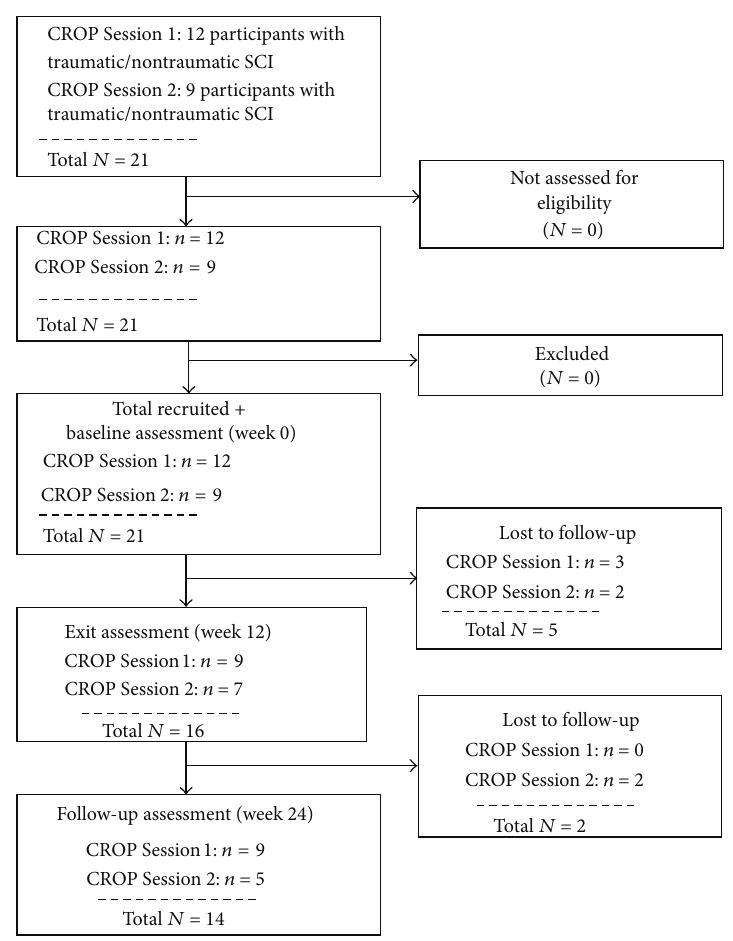
Figure 3: CROP service participant recruitment and assessment flow